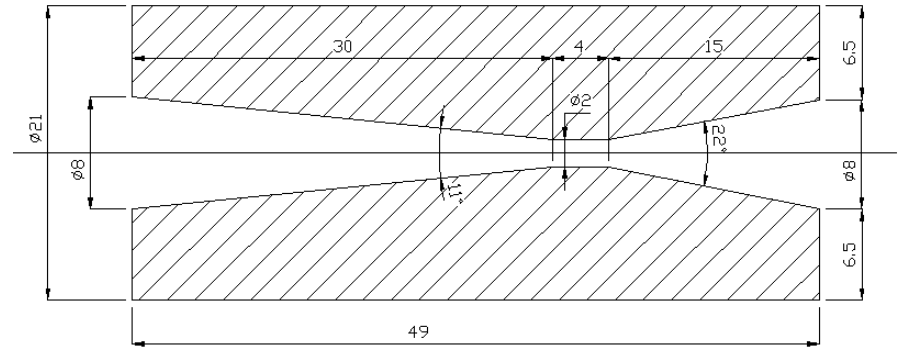
Unit:mm Unit:mm Unit:mm